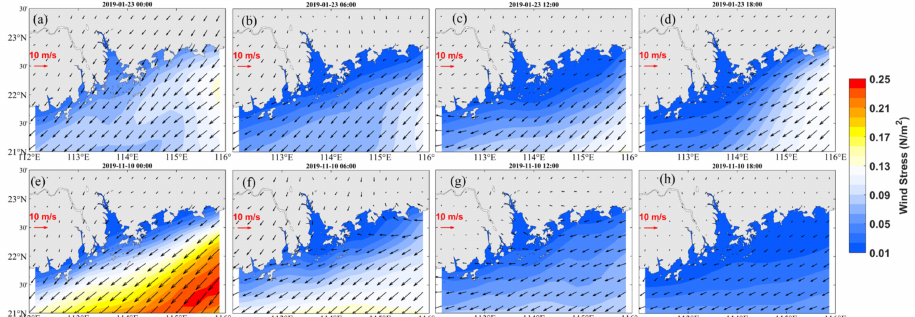
Figure 9. Six-hourly surface winds overlaid with wind stress (color shading) for 23 January ( a – d ) and 10 November 2019 ( e – h ). The subtitles in subplots ( a – h ) indicate the corresponding observation time (unit: UTC).